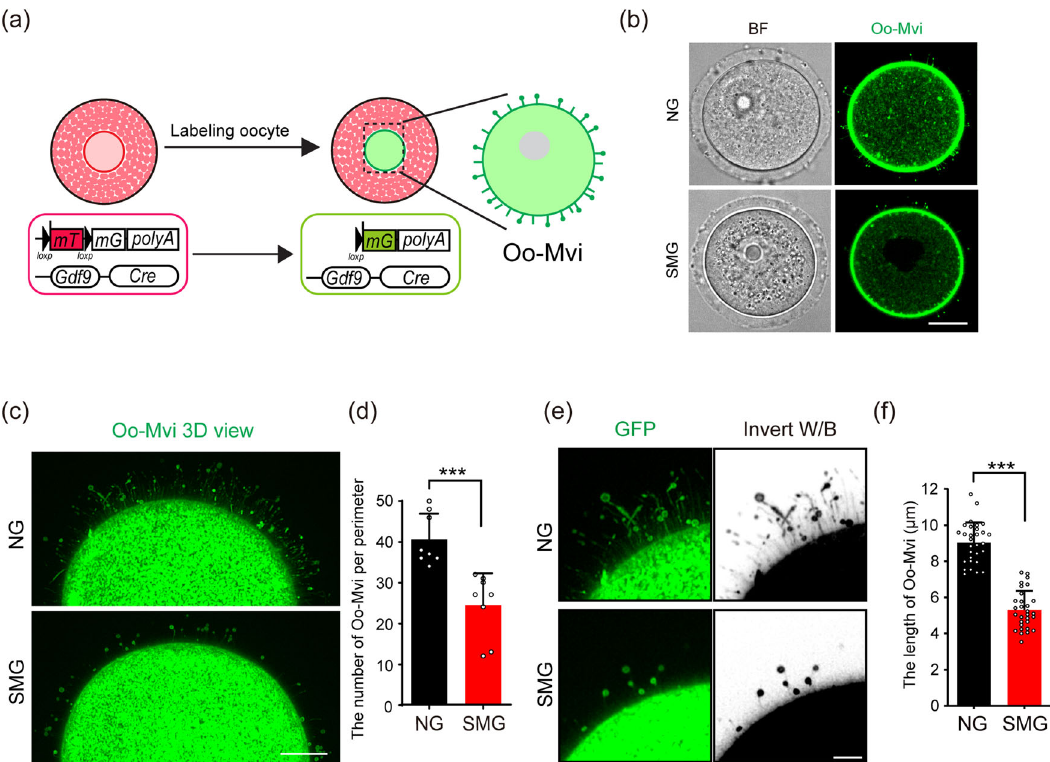
Fig. 4 SMG treatment decreased the formation of Oo-Mvi in cultured follicles. a Illustration of the strategy to label the Oo-Mvi by Gdf9- Cre;mTmG mouse model. The membrane-localized red fl uorescent protein (mT) switches to green- fl uorescent protein (mG) in oocytes of Gdf9- Cre;mTmG mouse to label oocyte membrane morphology. b Images of Gdf9-Cre;mTmG oocytes, showing the mushroom-like Oo-Mvi with vesicle tips distributed in the zona pellucida of oocytes in both the SMG and the NG groups. Scale bars, 30 μ m. c 3D high-resolution images showing a decreased density of Oo-Mvi on the oocytes ’ surface under SMG. Scale bars, 10 μ m. d Numbers of Oo-Mvi reduced in SMG oocytes ( n = 8) compared to that in NG ( n = 8), showing a signi fi cantly reduced number of Oo-Mvi on oocytes in follicles after SMG treatment. p value = 0.00052. e High magni fi cation showing that the length of Oo-Mvi in the SMG group was shorter than that in the NG group. Scale bars, 5 μ m. f Quanti fi cation of the length of Oo-Mvi con fi rmed a dramatic decrease in the SMG group ( n = 30) compared to that in the NG group ( n = 30). p value = 0.00000000000000000052. The colors were inverted to black/white (b/w) to highlight Oo-Mvi in ( e ). Representative images are shown. Data is presented as the mean ± SD. Data were analyzed by two-tailed unpaired Student ’ s t -test and *** P <